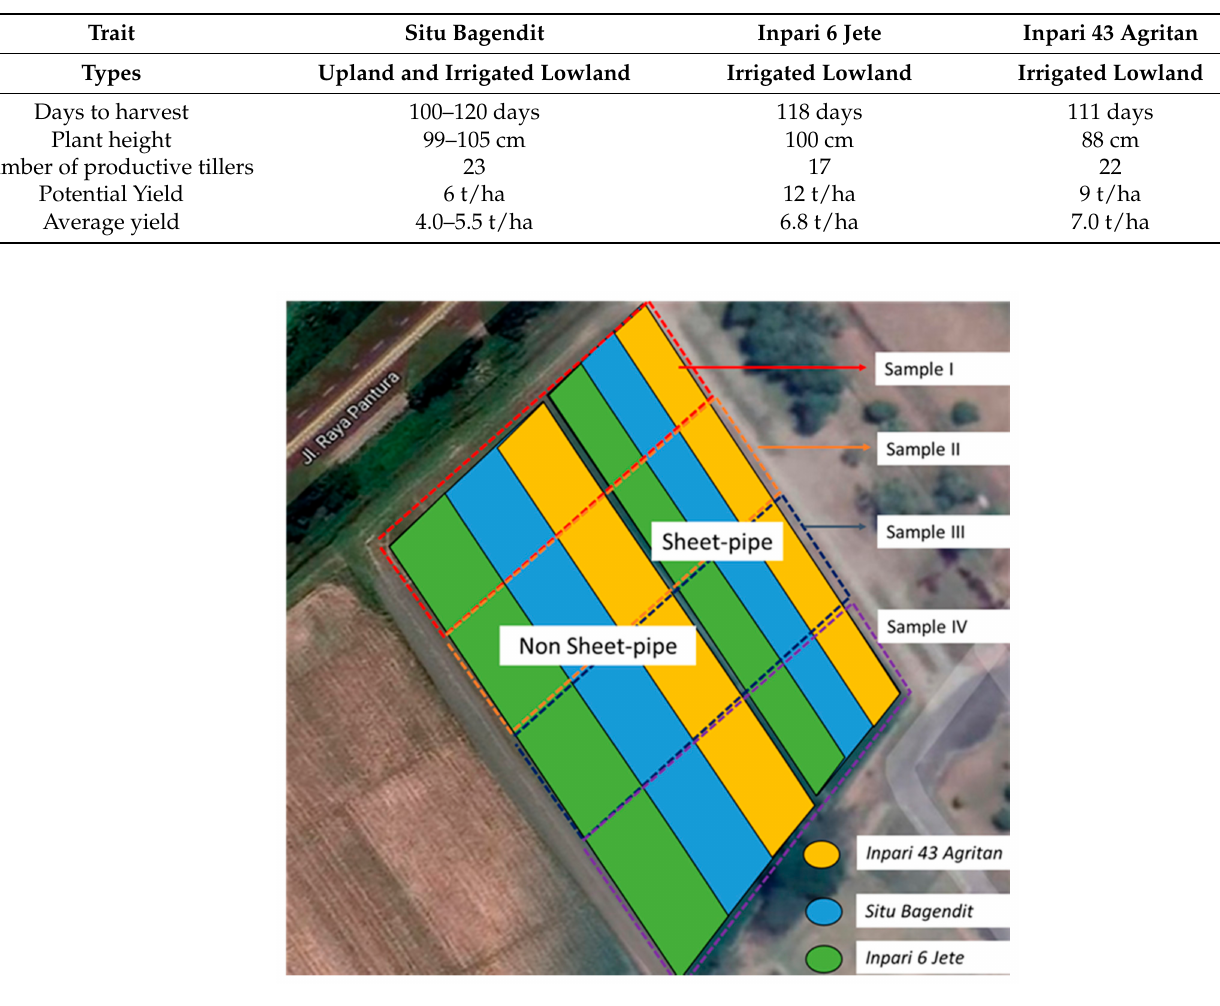
Figure 1. Layout of the three planted varieties in non sheet-pipe (NSP) and sheet-pipe (SP) fields. For installation of the sheet-pipe in the SP field, a machine called mole drainer ( Komatsu SP30 ) was used to pull it out at a depth of 40 cm with 100 m length. The sheet- pipe will be a pipe with 5 cm in diameter and 1 mm in thickness during